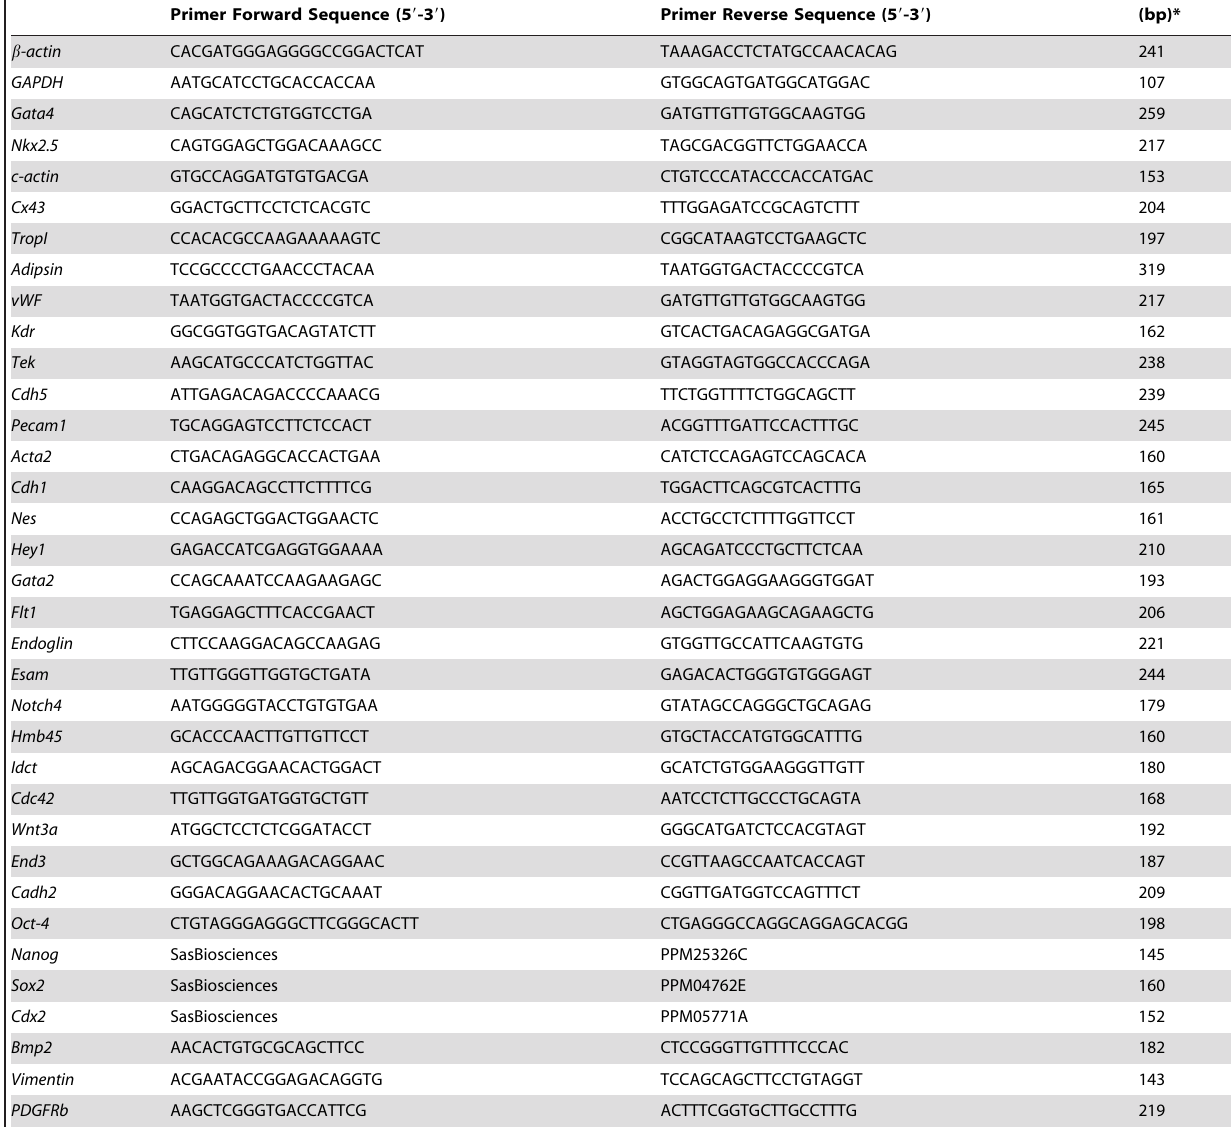
Table 2. Primer sequences for